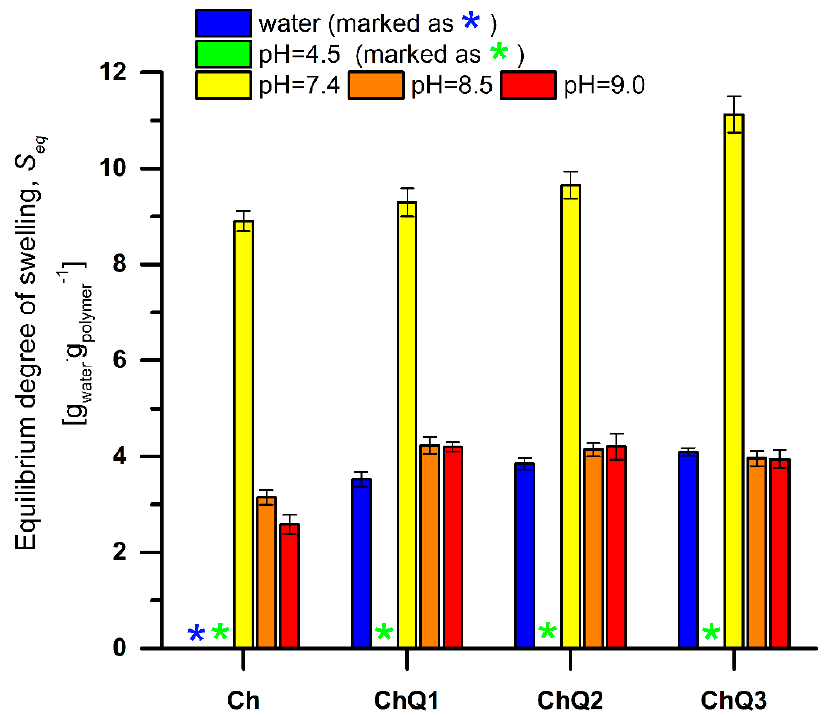
Figure 5. Equilibrium swelling degree of non-modified and squaric acid-crosslinked chitosan films in water and different buffered solutions.